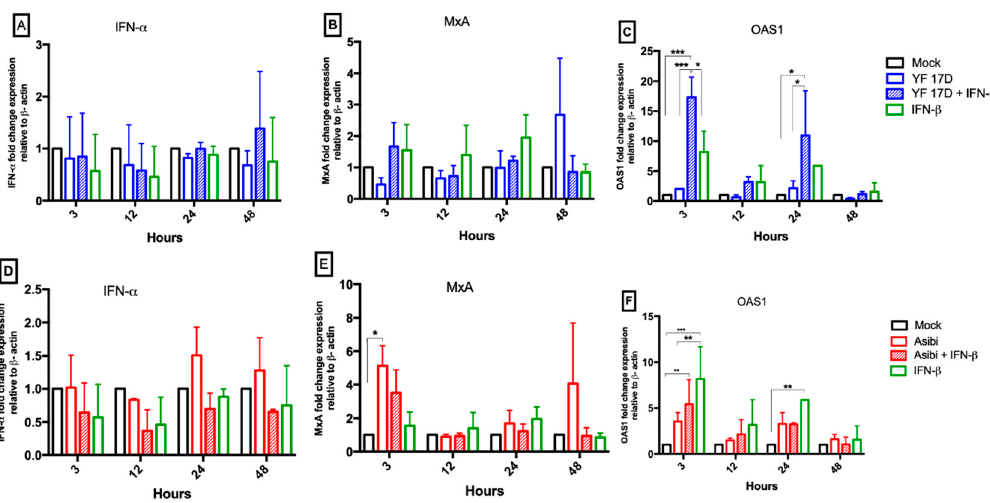
Figure 6. E ff ect of IFN- β on YFV induction of antiviral molecules. Hela cells were either or not stimulated with IFN- β for six hours and subsequently infected with YF-17D or Asibi at MOI = 1. IFN- β -stimulated and un-stimulated uninfected cells served as stimulated / positive and mock controls, respectively. At the indicated time points, cells were processed, and RNA extracted. Expression levels of antiviral molecules IFN- α ( A , D ), MxA ( B , E ) and OAS1 ( C , F ) were determined by RT q-PCR and expression levels expressed as fold change compared to the expression levels in mock uninfected HeLa cells with β -actin as endogenous control. Data are representative of two independent experiments performed in triplicates and are presented as Mean ± SEM. * = p ≤ 0.05, ** = p ≤ 0.01,*** = p ≤ 0.001. IFN = interferon- β .